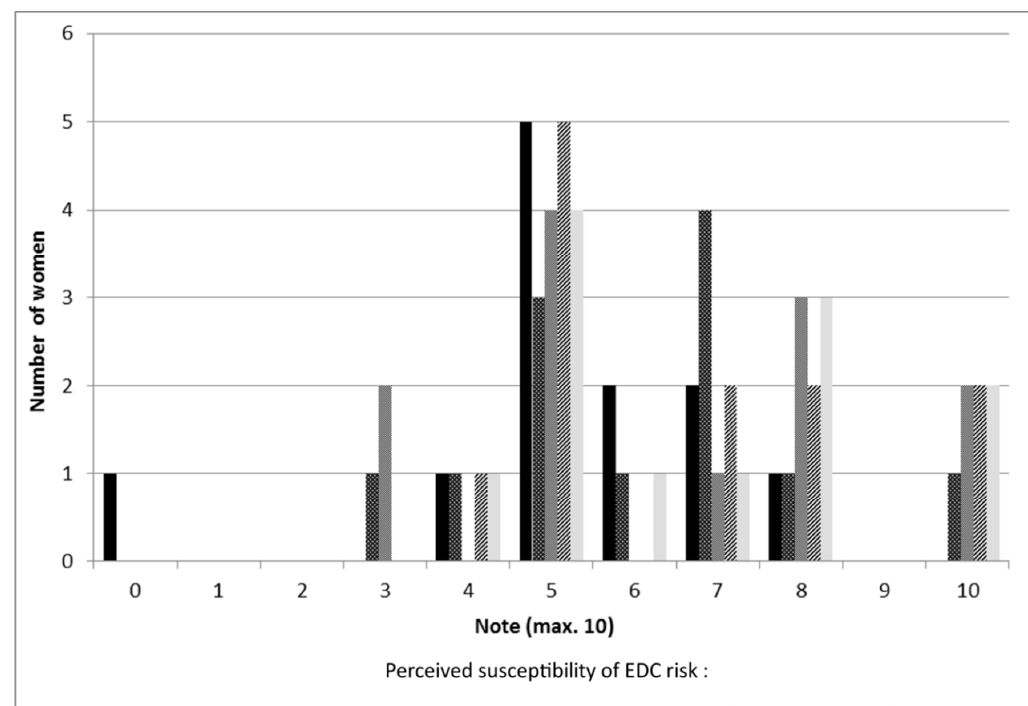
Figure A2. Distribution of pregnant women’s perceived susceptibility to endocrine disrupting chemicals (EDC) risk exposure (qualitative study, n = 12).